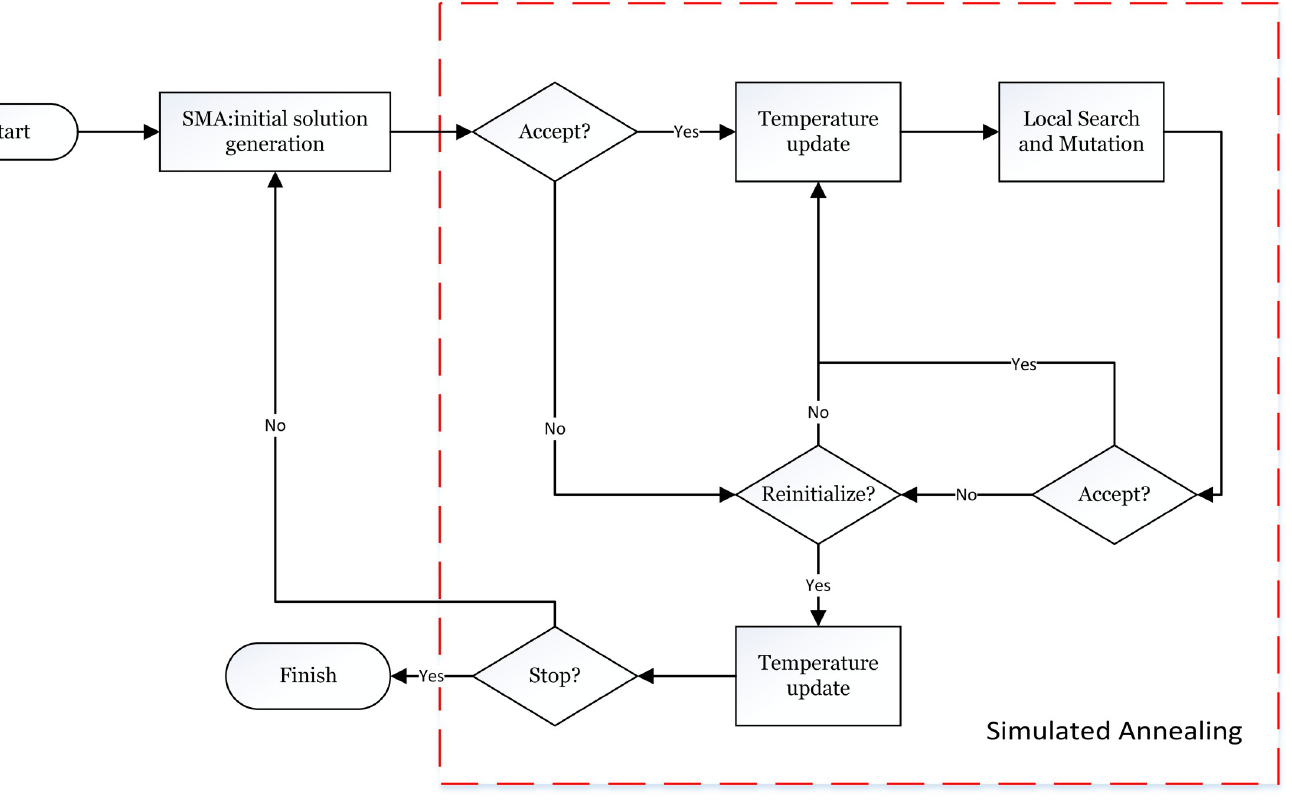
PLOS ONE | https://doi.org/10.1371/journal.pone.0280512 January 25,